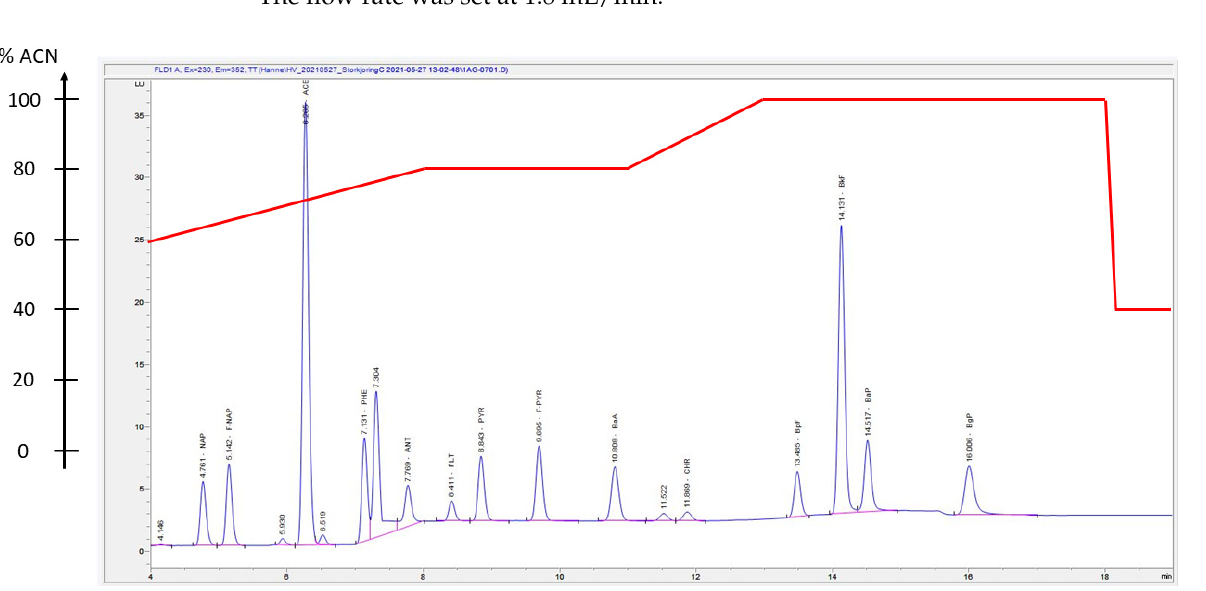
Figure 5. HPLC-FLD chromatogram presenting the elution order of 15 PAH target analytes. The sample was a calibration standard sample with a concentration of 100 µ g/L of each PAH target analyte. Elution order: NAP, F-NAP, ACE, PHE, ANT, FLT, PYR, F-PYR, BaA, CHR, BpF, BkF, BaP, BgP. The elution solvent gradient, shown as percentage of acetonitrile (ACN) is presented superimposed on the chromatogram (red line). The solvent gradient percentages are listed in Supplementary Information (Table S5).